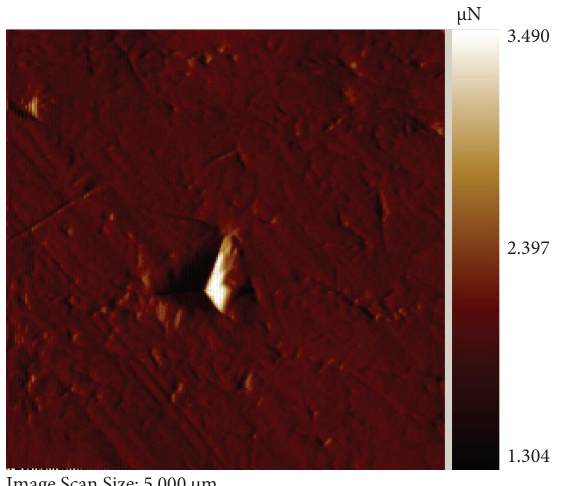
Figure 3: Indents formed by